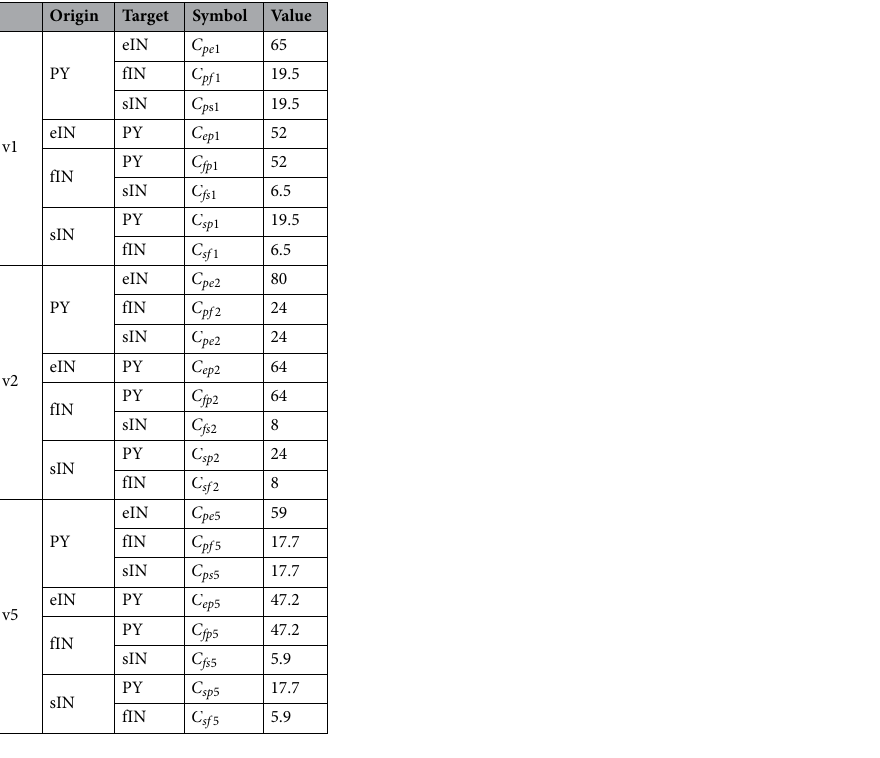
Table 1. Parameters of synaptic connections among different neuronal populations within each cortical